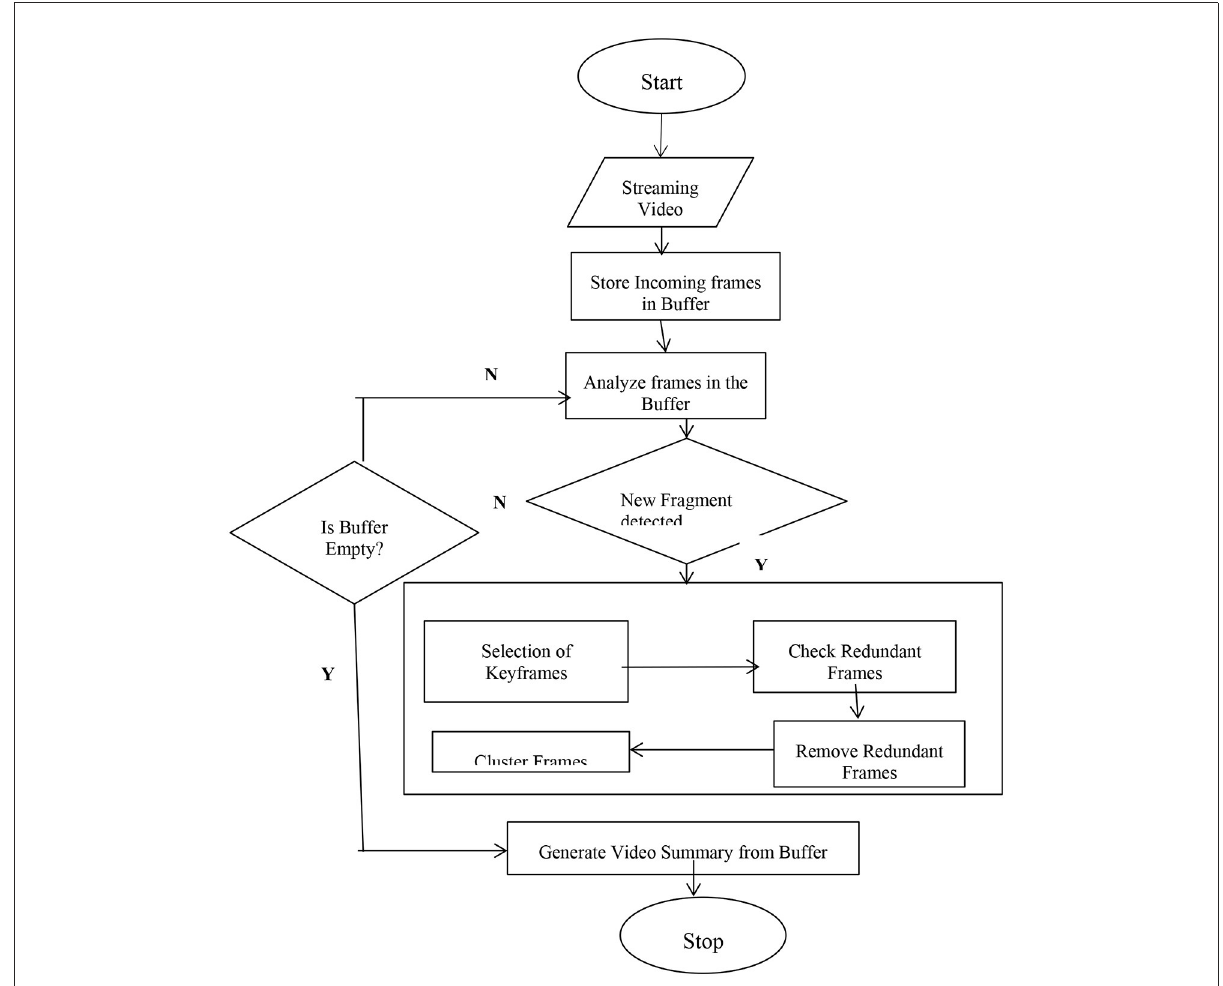
FIGURE2 Flowchart of real time video